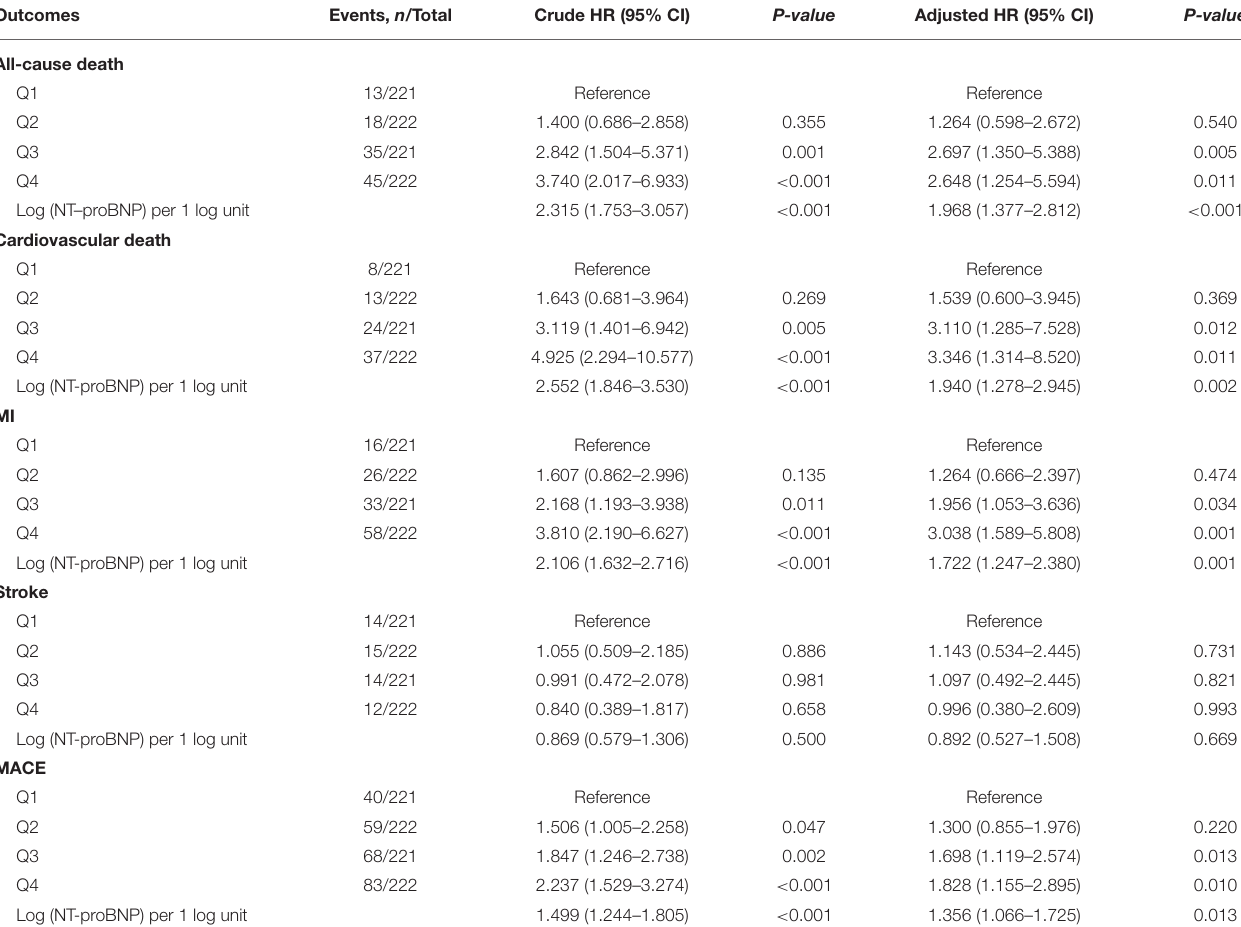
TABLE 2 | Cox univariate and multivariate analysis of the association between NT-proBNP levels and endpoints.